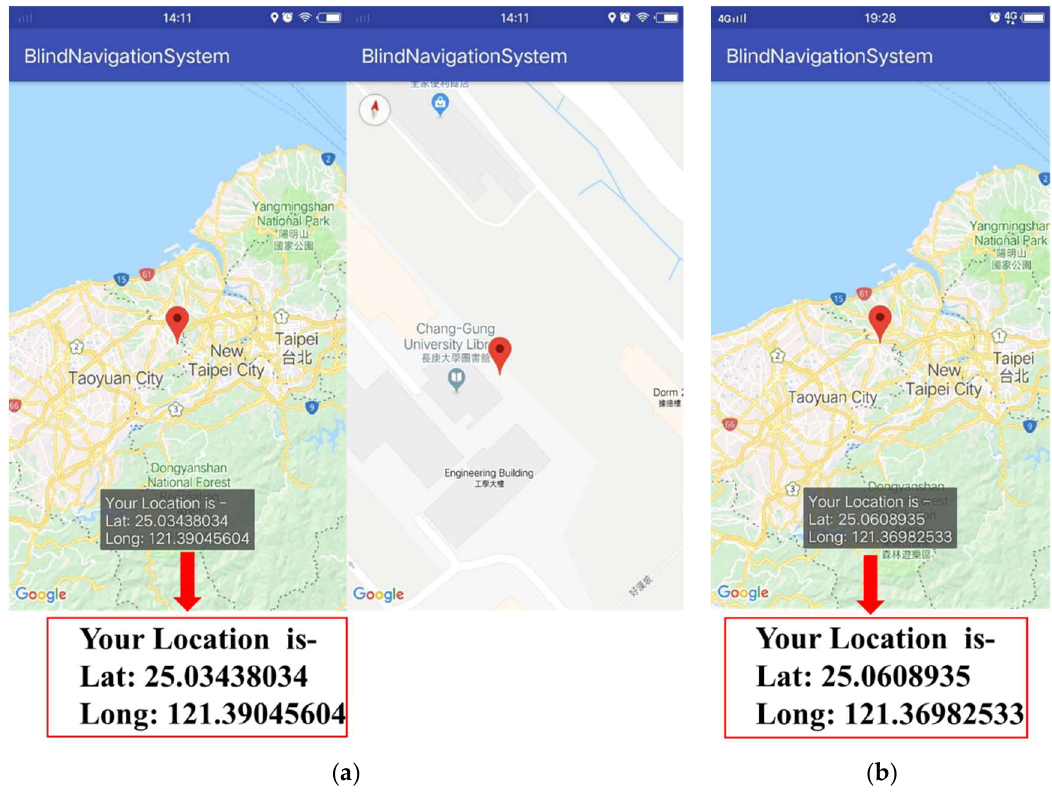
Figure 8. APP showing the user location at ( a ) Chang Gung University library; ( b ) Taoyuan Airport MRT A8.